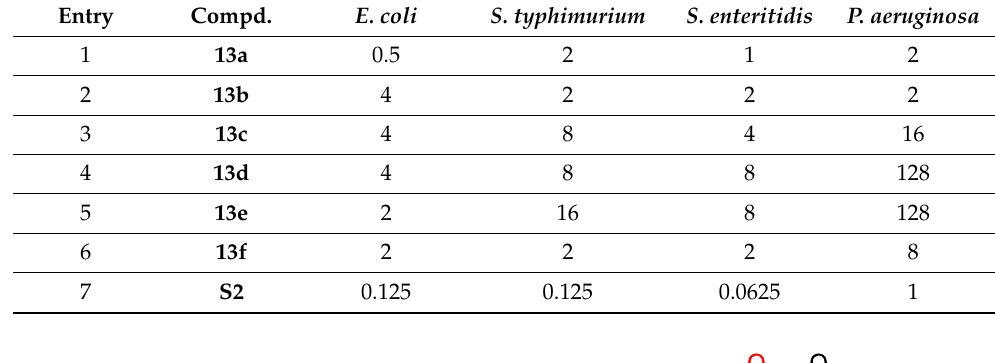
Table 2. MIC (µg/mL) values of compound 13a – f .